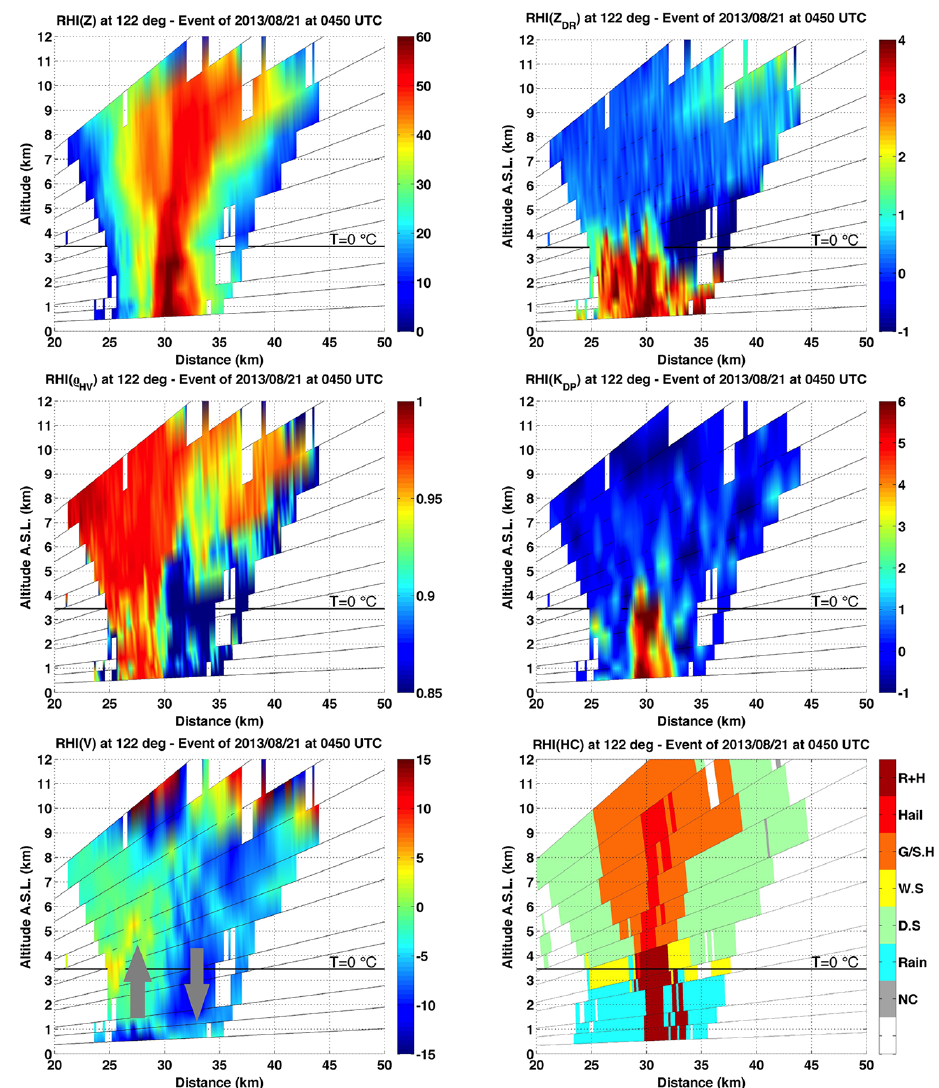
Figure 14. Vertical cut of Z H (upper left panel), Z DR (upper right panel), ρ HV (middle left panel), K DP (middle right panel), radial velocity (lower left panel) and hydrometeor classes (lower right panel) taken at 122 ◦ of azimuth on the 21 August 2013 at